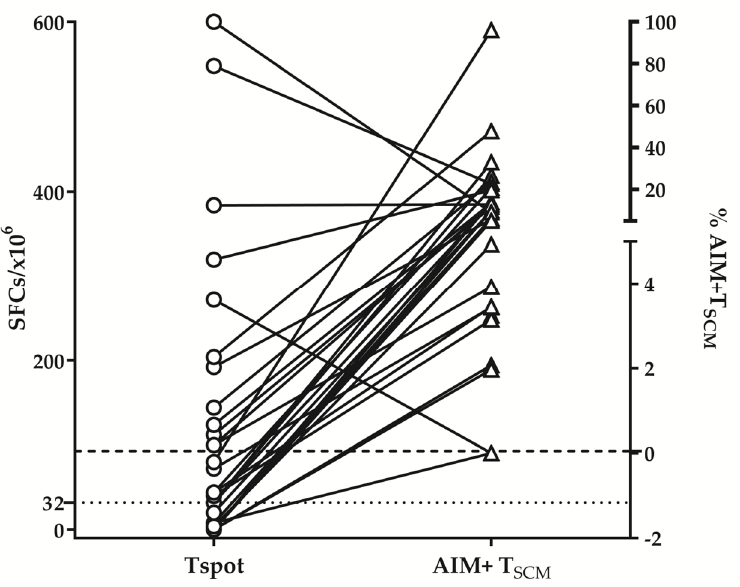
Figure 7. ELISpot and flow cytometry results regarding memory T-cell responses. Comparison between the share of virus-specific memory T cells determined by ELISpot and by flow cytometry detection of AIM+ T SCM , paired data. Both samples acquired before and beyond 9 months post-infection are included. The doed and dashed lines correspond to the cut-off levels of ELISpot (32 SFCs/10 6 PMBCs) and flow cytometry AIM test, respectively.